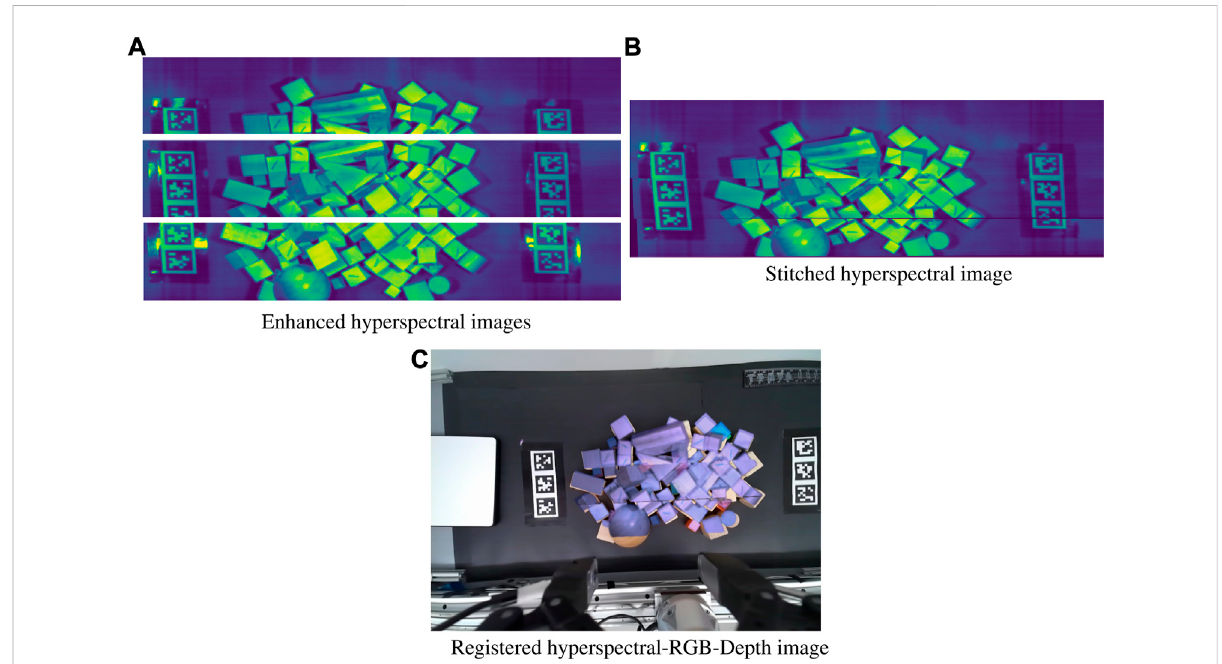
FIGURE 3 Image registration with (A) Noise fi ltering, sharpening, and CLAHE applied to each respective image (B) Enhanced images stitched together from shared features and homography (C) Stitched hyperspectral image warped to directly correspond to the RGB image from shared features, and overlaid for visualization.